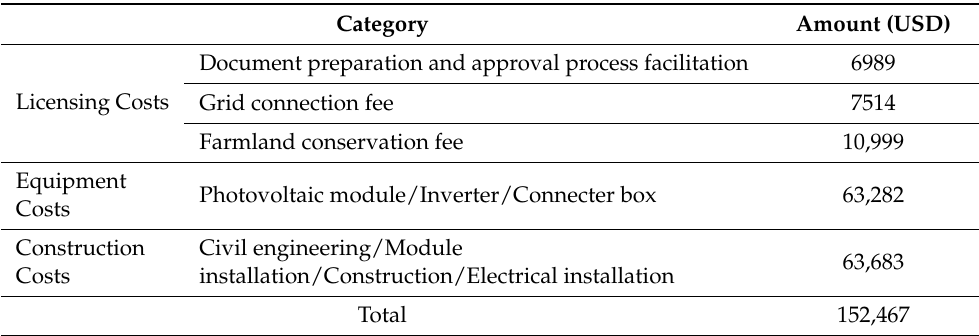
Table 5. APV installation costs